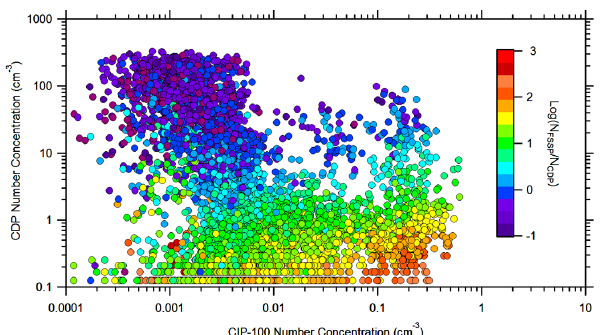
Fig. A2. Histogram of FSSP and CDP number concentrations mea- sured in frontal cloud during flight